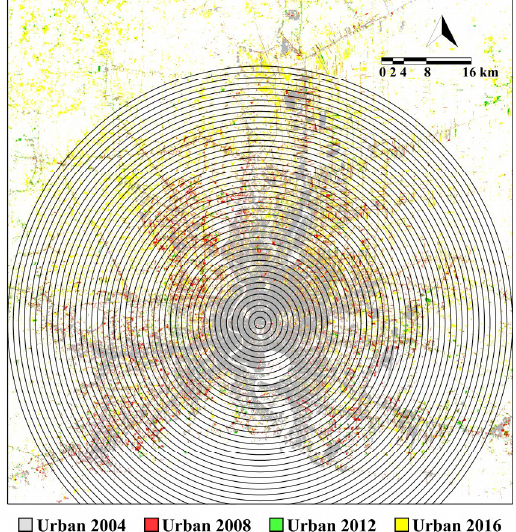
Figure 3. The concentric ring-based partitioning of Bangkok for the four years. Ring distance is 1 km.